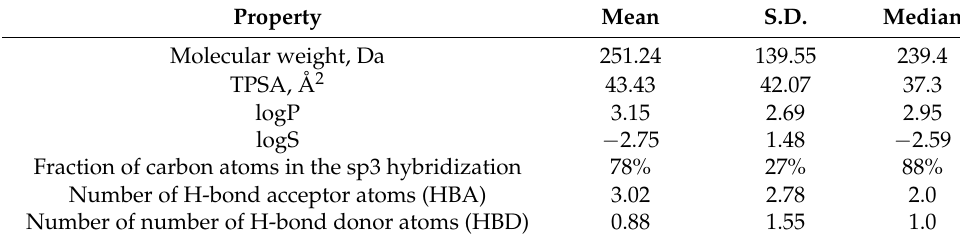
Figure 5. Distributions of chemical descriptors and properties for compounds present in CPE-DB. ( a ) molecular weight; ( b ) topological polar surface area (TPSA); ( c ) predicted partition coefficient (logP); ( d ) predicted solubility (logS); ( e ) fraction of carbon atoms in sp3 hybridization; ( f ) number of hydrogen bond acceptors; ( g ) number of hydrogen bond donors; ( h ) number of rotatable bonds; ( i ) total number of ring systems; ( j ) number of aromatic rings. Table 2. Average values of chemical descriptors and properties for compounds present in CPE-DB.